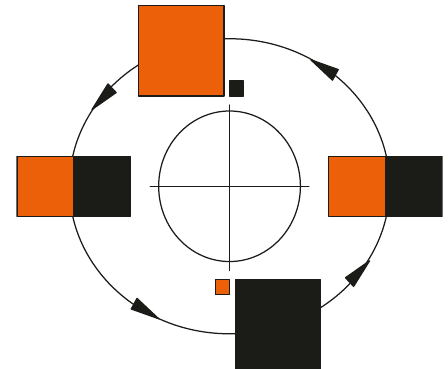
Figure 2: Schematic diagram of the tai chi diagram model under the new mathematical model.